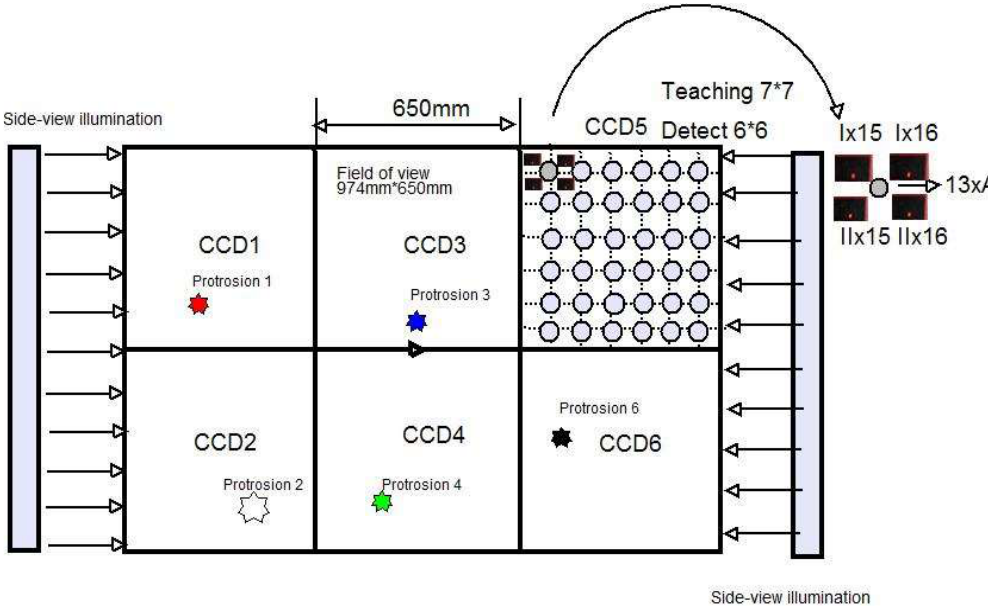
Figure 7. Topology of six charge-coupled devices (CCDs) in field of view for the tuning template [1].